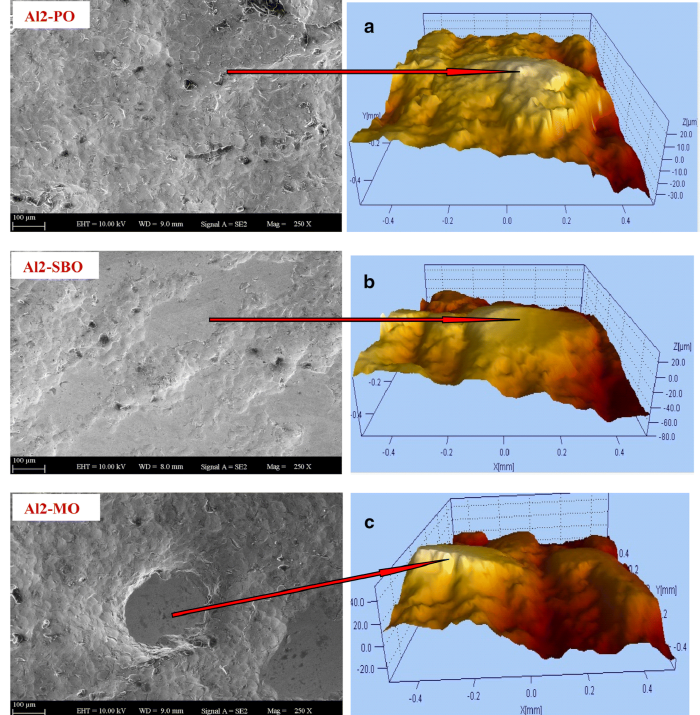
Figure 11. SEM images ( left ) and 3D optical profilometer images ( right ) of wear tracks of laser peening surfaces. ( a ) with palm oil. ( b ) with soybean oil. ( c ) with machine oil. (Reprinted with permission from ref. [110]. Copyright 2019